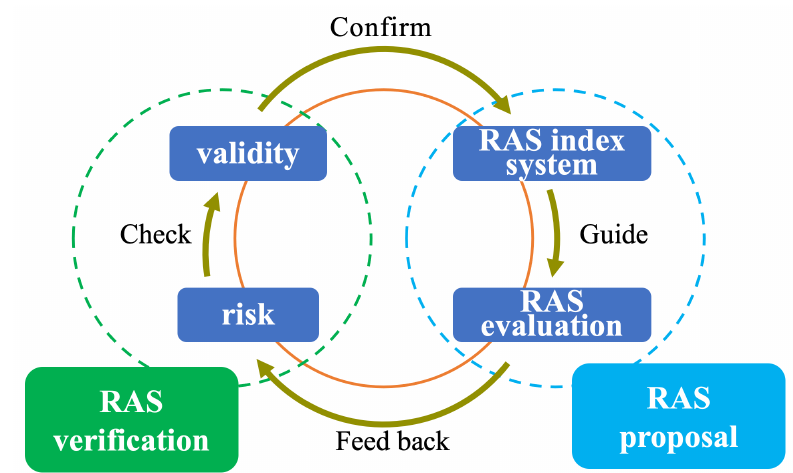
Figure 3. Closed-loop framework of the risk assessment system.